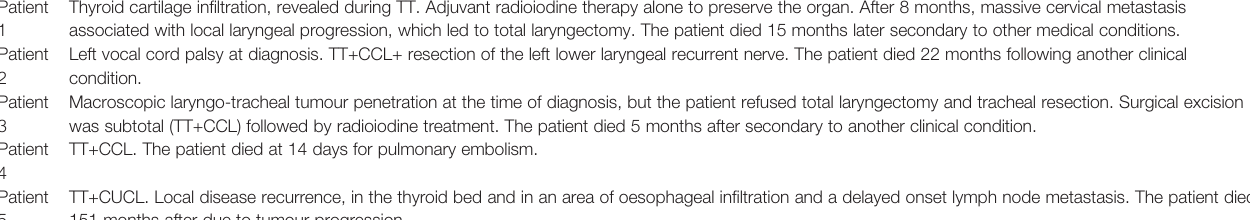
TABLE 5 | Clinical history and treatment of the eight deceased patients. Patient